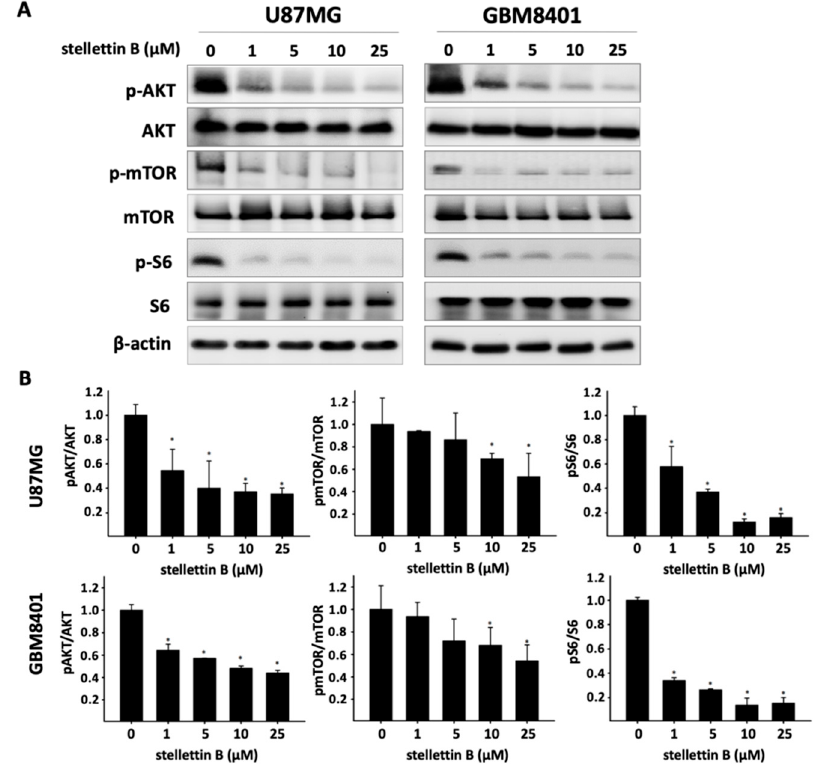
Figure 3. Effect of stellettin B on the Akt/mTOR pathway in glioblastoma cells. ( A ) U87MG and GBM8401 cells were treated with 0, 1, 5, 10, or 25 µ M stellettin B for 24 h. Western blot analysis was performed to study the expression of p-Akt, Akt, p-mTOR, mTOR, pS6, and S6. β -Actin was used as a loading control. ( B ) p-Akt/Akt, p-mTOR/mTOR, and p-S6/S6 were quantified. Values are